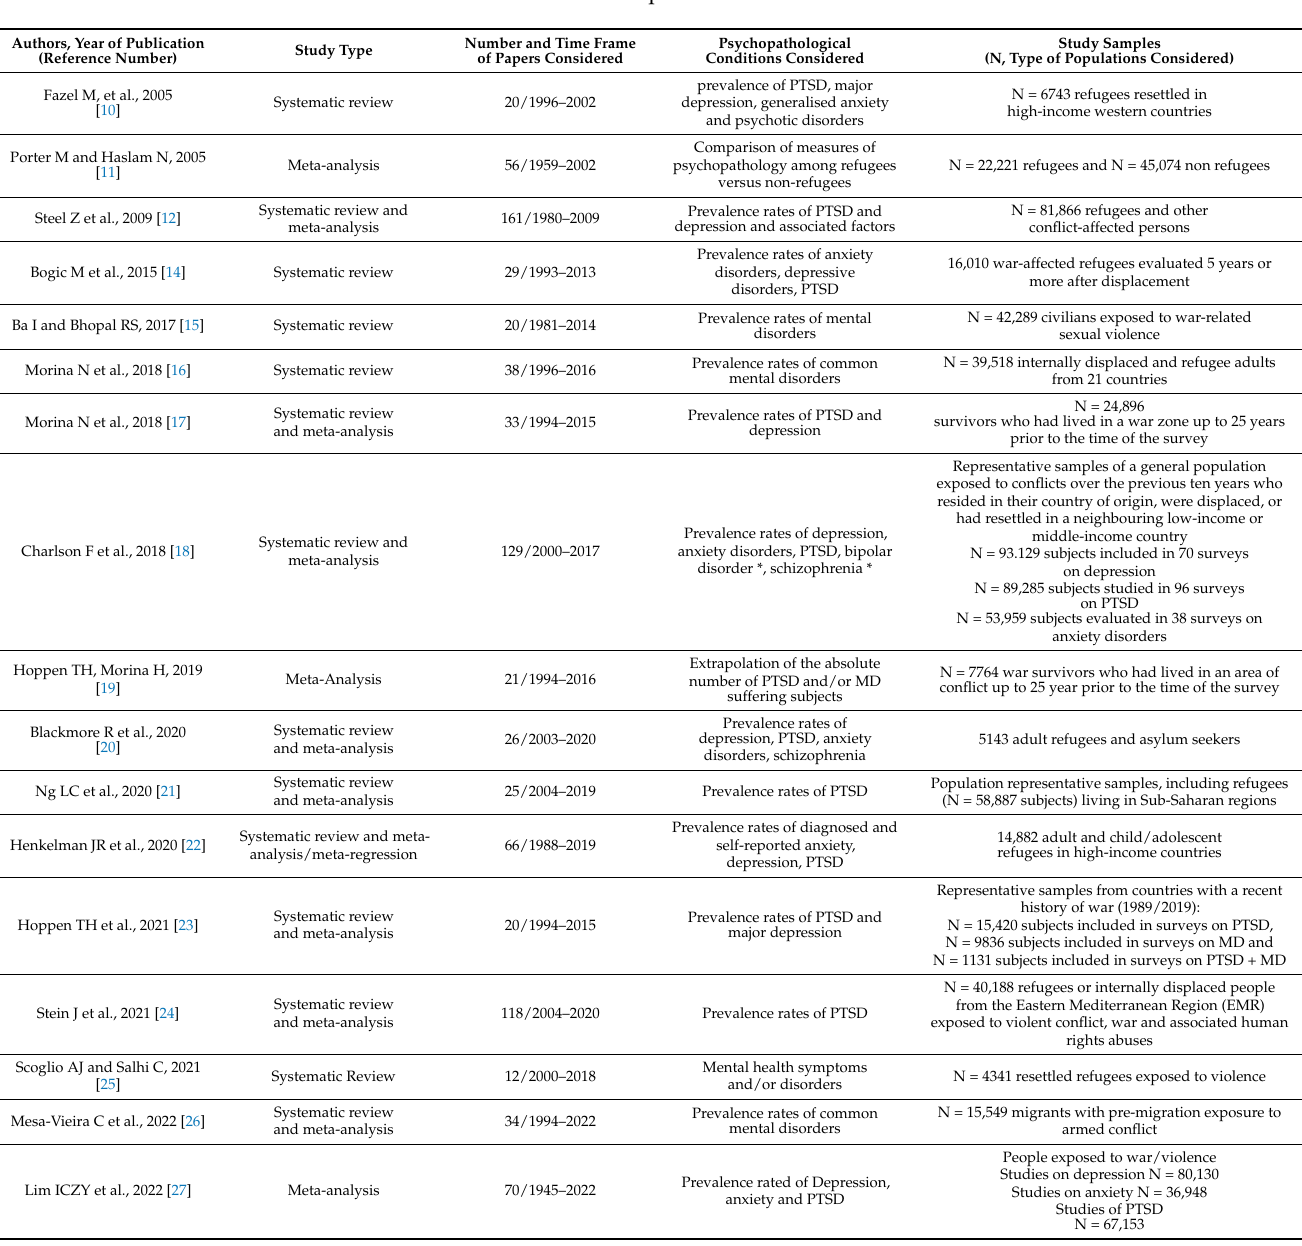
Table 1. Systematic reviews and/or meta-analyses relating to the mental health consequences of conflicts conducted on adult